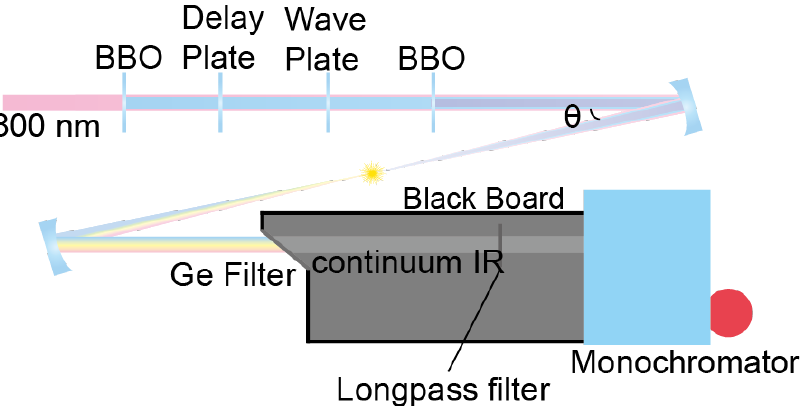
Figure 5. Continuum IR generation setup based on plasma generation. The captured photo of the setup can be seen in Figure S2.